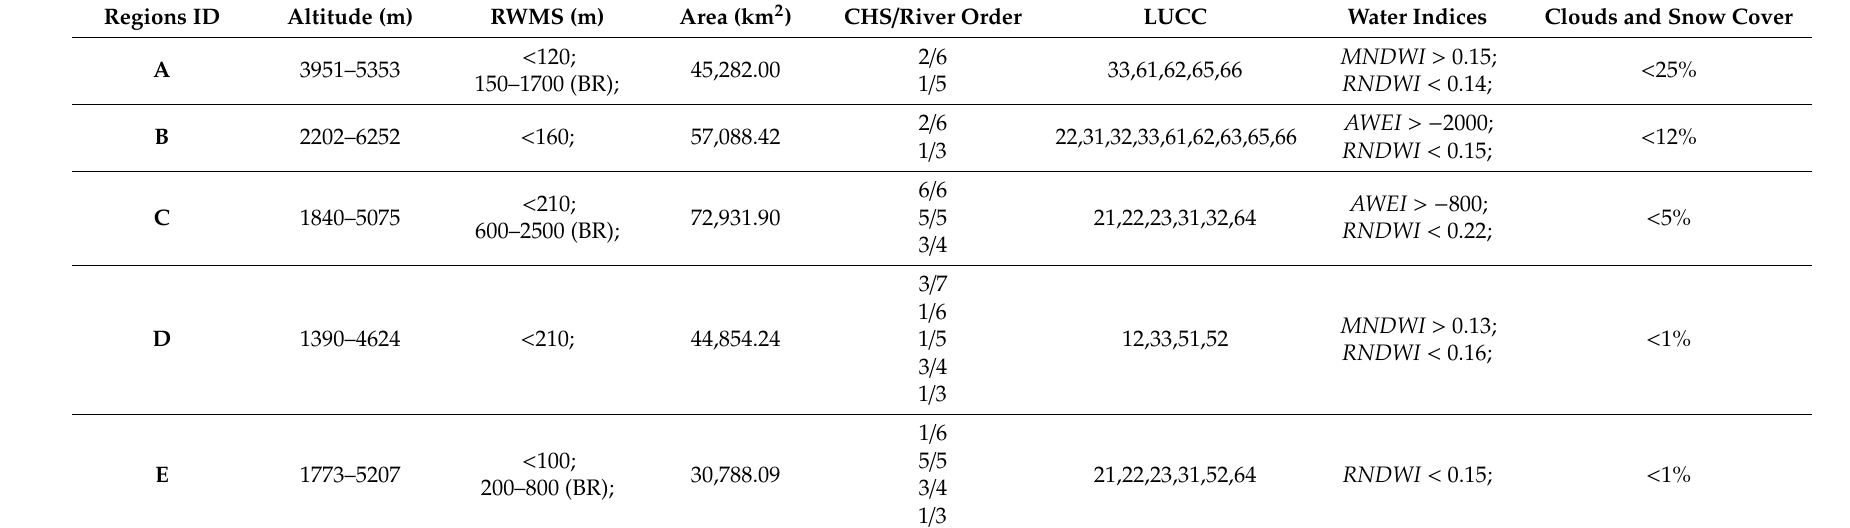
Table 2. Sub-regions feature